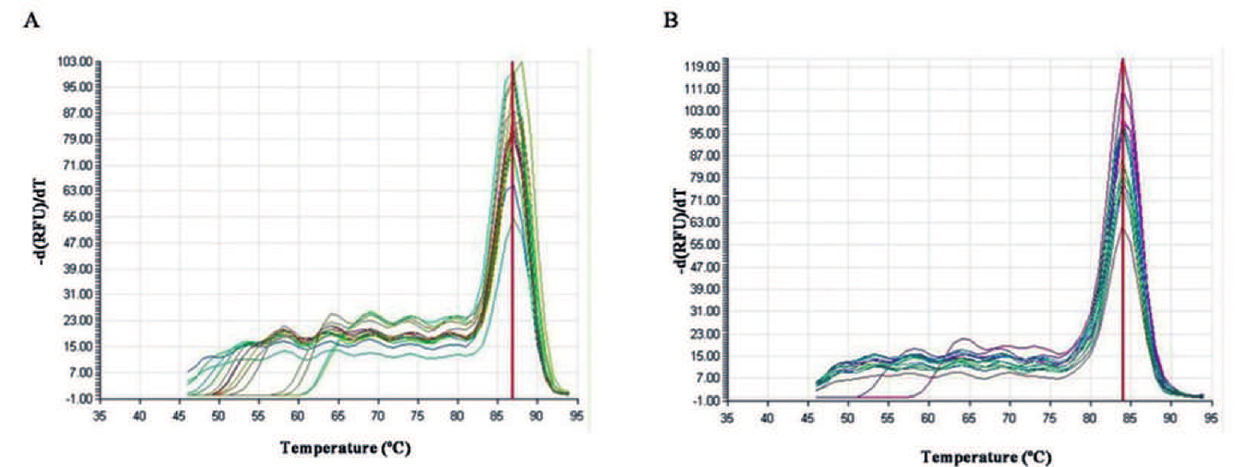
Fig. 1. The melting curves of (A) the samples, and (B) the control. Note the melting temperatures were 87 o C and 84 o C,